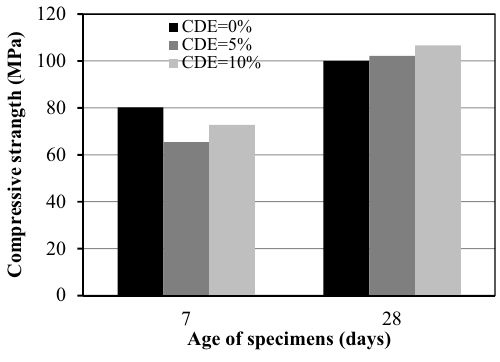
Figure 10: Compressive strength of UHPC.